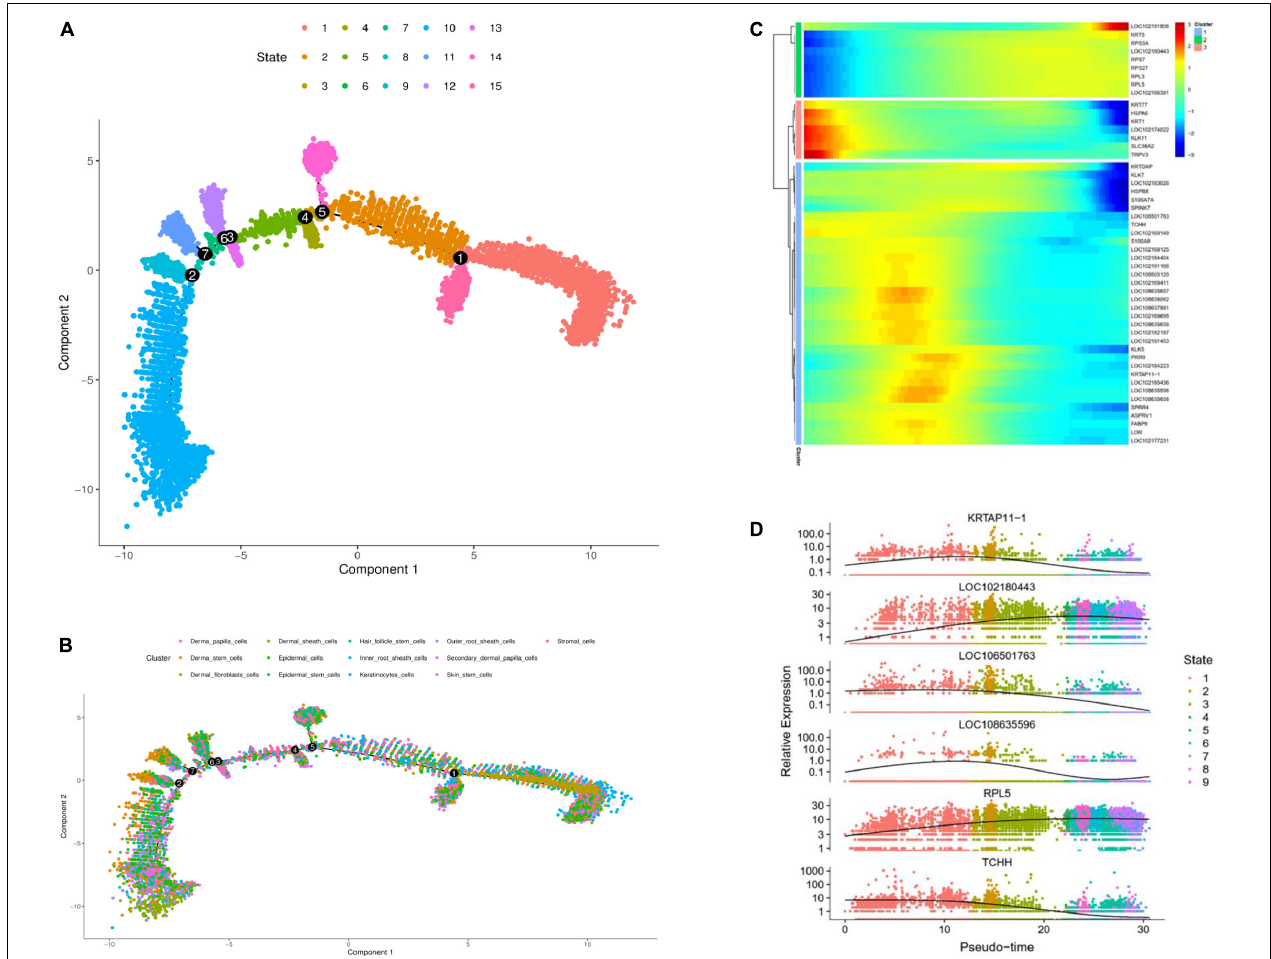
FIGURE 2 | Cell trajectory analysis on goat skin cells. (A) Monocle 2 cell trajectory analysis of goat skin cells. (B) Monocle 2 cell trajectory colored according to the identity of 13 goat skin cells. (C) Clustering of genes represent differential expression patterns across goat skin cell populations. (D) Dynamic expression values of top six different genes are plotted on pseudo-time. X -axis represents pseudo time, and Y -axis represents gene expression levels.